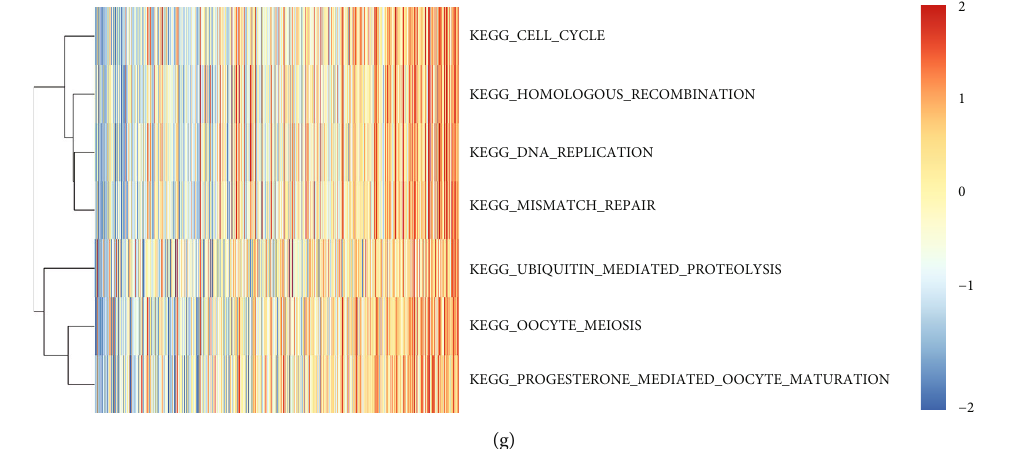
Figure 7: Results of the univariate and multivariate Cox regression analyses regarding disease-free survival in TCGA cohort (a, b). A nomogram of the breast cancer cohort (training set) was used to predict the disease-free survival (c). Calibration maps were used to predict 1-, 3-, and 5-year survival times (d). A decision curve analysis was used to compare the clinical usefulness of nomography with that of age, TNM stage, and tumor stage based on the threshold probability (e). A gene set enrichment analysis was performed. (f) The heat map shows the correlation between the risk scores and the top 7 KEGG pathways and the relationships among the KEGG pathways ( correlation coefficient > 0 : 4 and p < 0 : 05 ). (g) Clustering of 7 KEGG pathways and the heat map show the risk score of each case in the top 7 KEGG pathways. The horizontal axis represents the breast cancer samples, and the risk score increases from left to